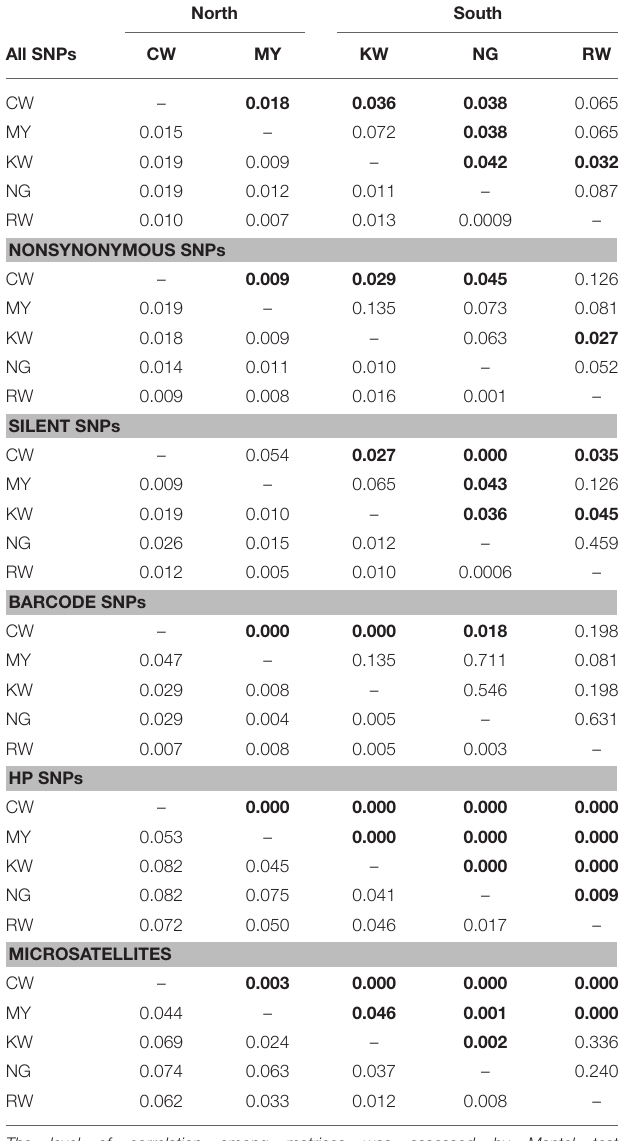
TABLE 2 | Information of microsatellite loci used in the present study. Chromosome Locus